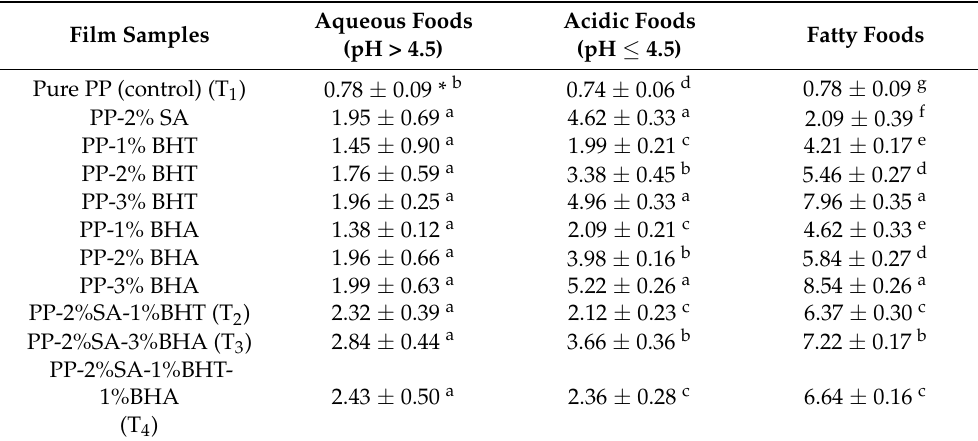
Table 6. Migration behaviour of composite films incorporating single or a combination of antimicro- bial/antioxidant additives in aqueous, acidic and fatty food simulants. Aqueous Foods Acidic Foods Fatty Foods Film Samples (pH > 4.5) (pH ≤ 4.5) Pure PP (control) (T 1